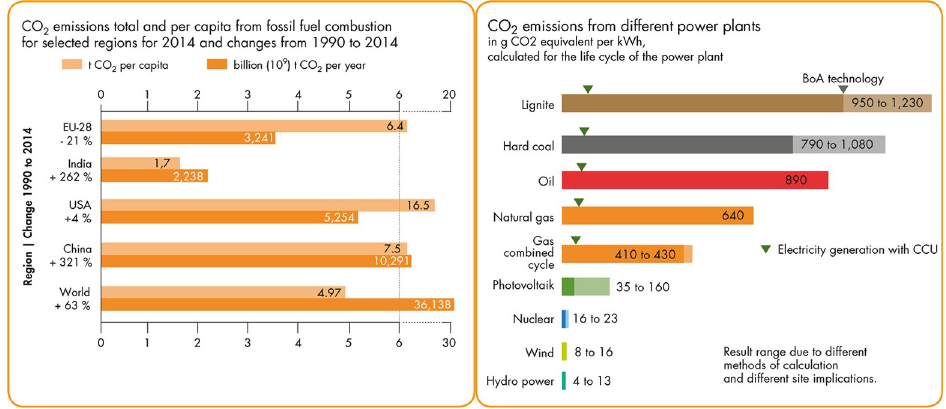
Fig. 7. – Carbon dioxide (CO 2 ) emissions in selected regions of the world (left) and from different types of power plants (right)